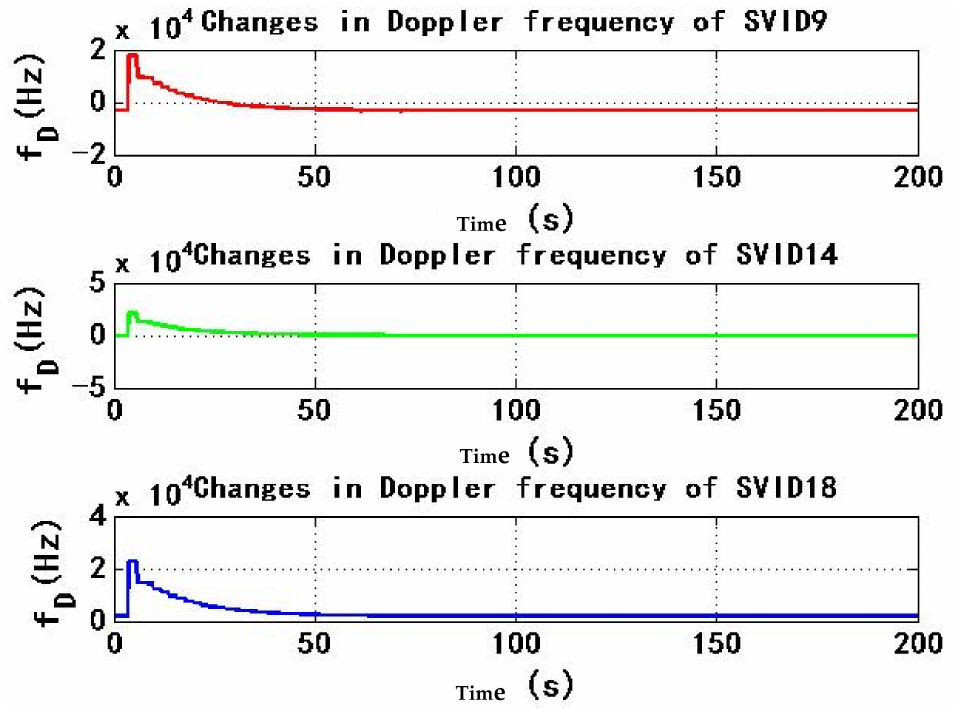
Figure 13. Changes in Doppler frequency of SVID9, 14, 18 in experiment